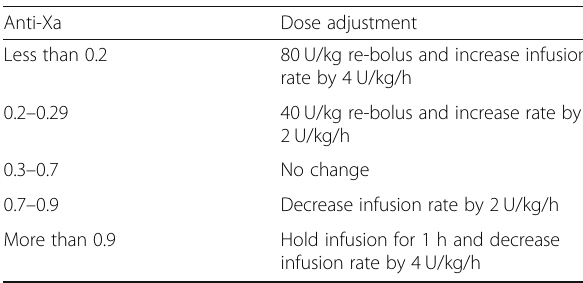
Table 4 Comparison between the two groups as regards the platelet count